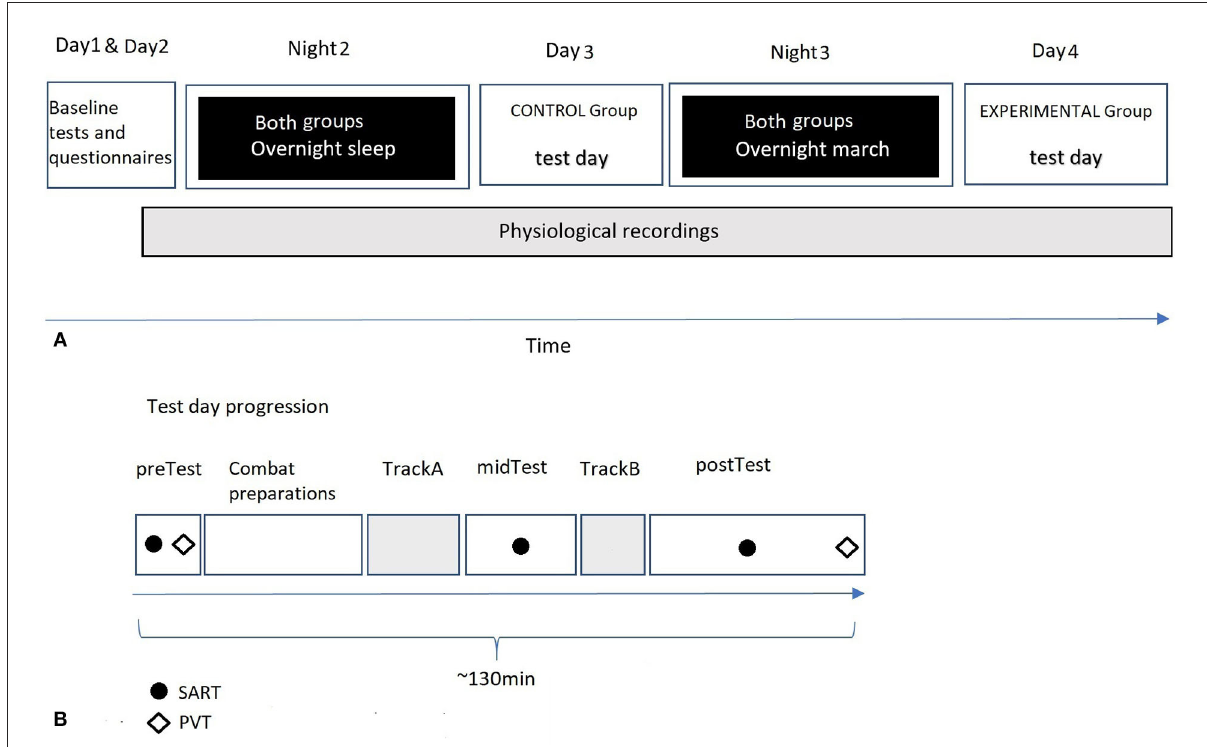
FIGURE1 (A) The temporal order of the main events throughout the whole study. (B) A three-person drill team’s test day procedure. The sustained attention to response task (SART) and psychometric vigilance task (PVT) were performed in the order displayed in the picture with a comparative in-between task